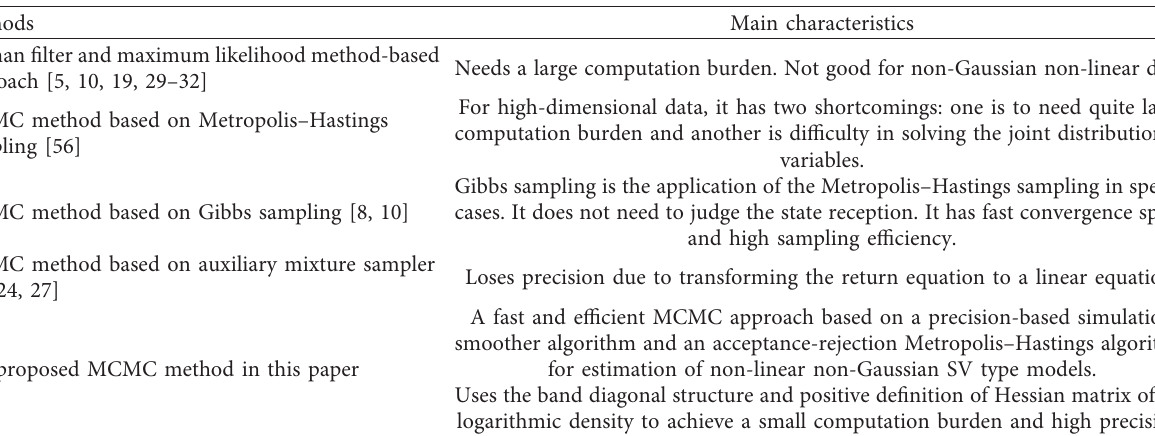
Table 2: Difference between previous research and our research in this paper.